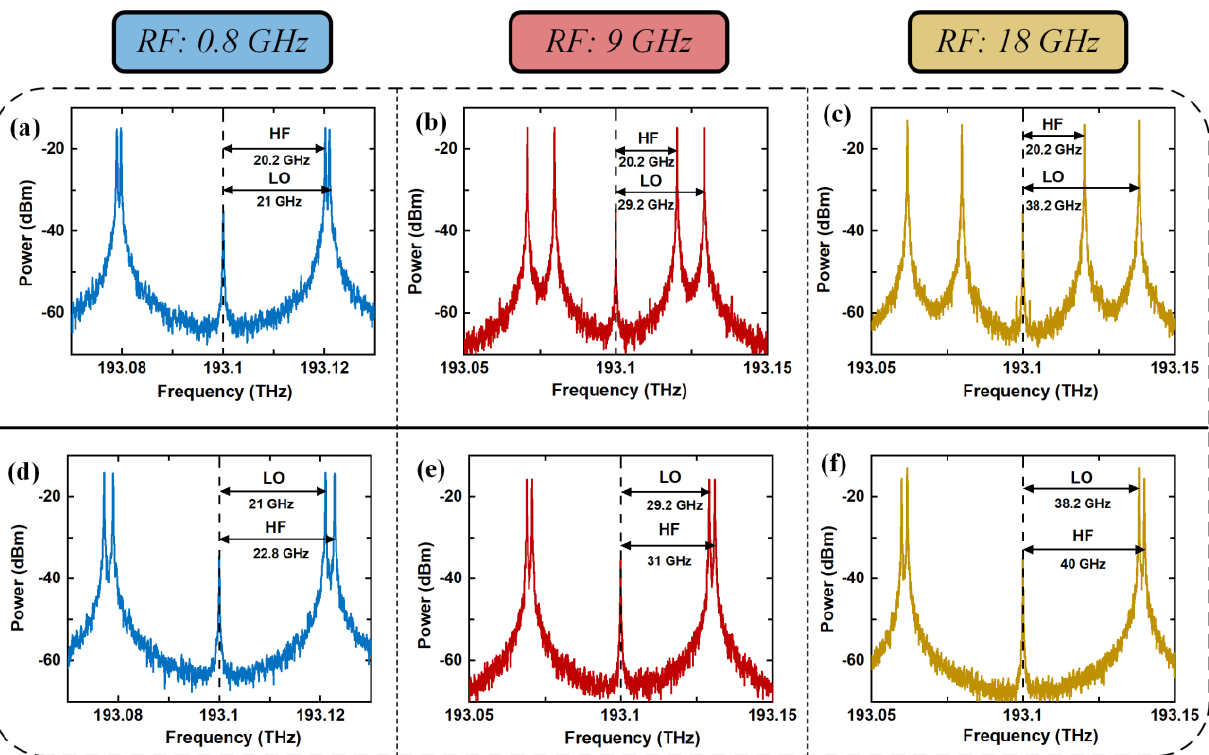
Figure 3. Simulated optical spectrum of upconversion ( a – c ) and downconversion ( d – f ) when RF signal has the frequencies of 0.8 GHz, 9 GHz, and 18 GHz.